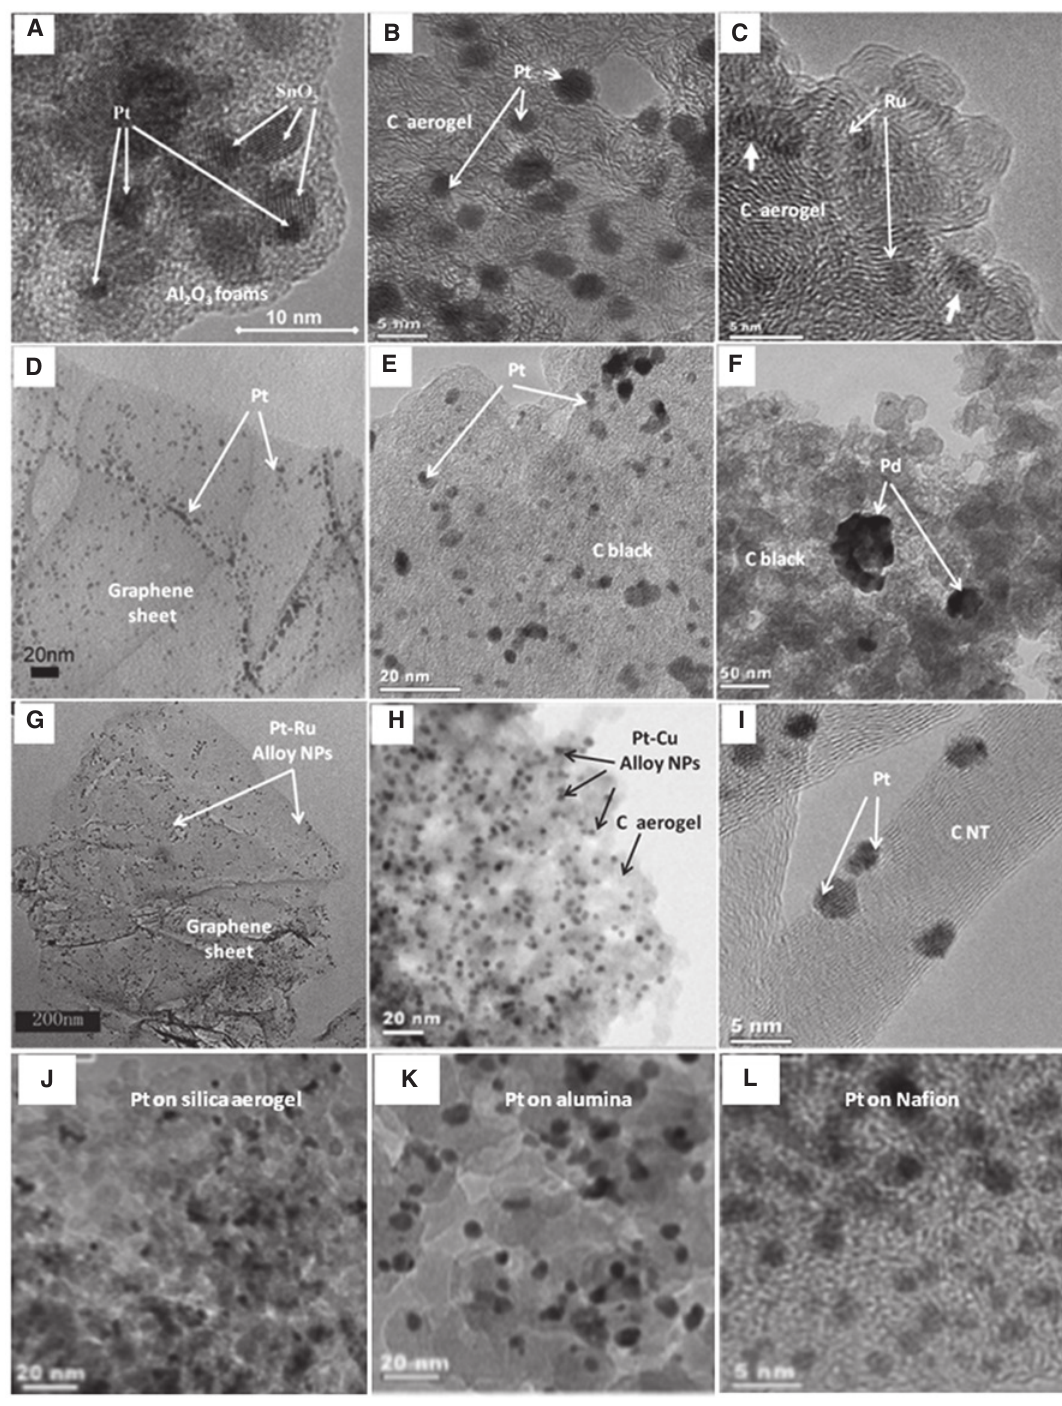
Figure 6: Different metal NPs deposited onto ceramic foams, carbon type, oxide type, or Nafion film supports with thermodynamically